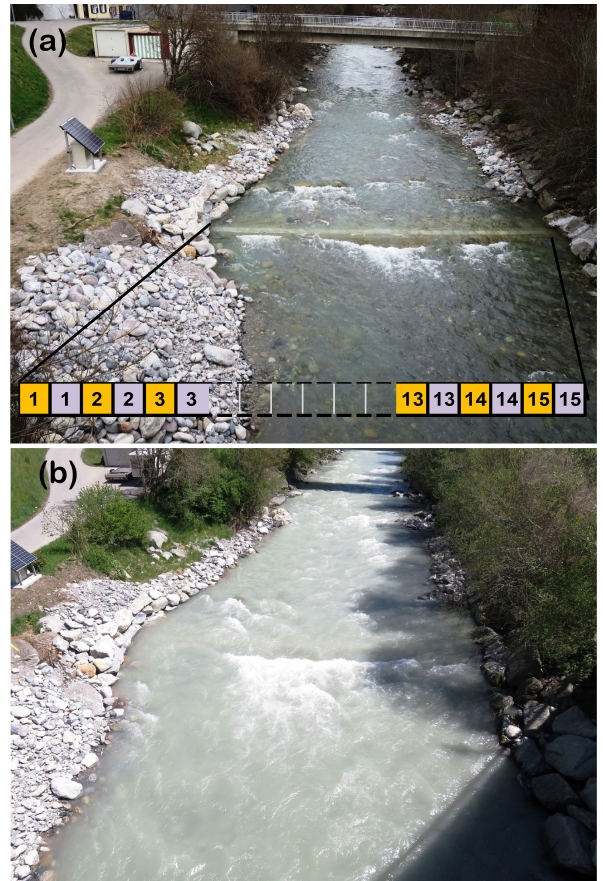
Figure 1. Bedload measuring site in the Albula River in Tiefencas- tel, Switzerland. Steel plates with acoustic sensors are embedded into a sill. The width of the sill is 15m, including a total of 30 steel plates with one sensor under each plate. Both geophones and accelerometers are installed. The view on the photos is upstream. (a) Low flow conditions on 16 April 2015 with a discharge of about 2m 3 s − 1 ; numbers with yellow background refer to geophone sen- sors, numbers with violet background to accelerometer sensors (see also Table 1); (b) medium flow conditions on 7 May 2015 with a discharge of about 8m 3 s − 1